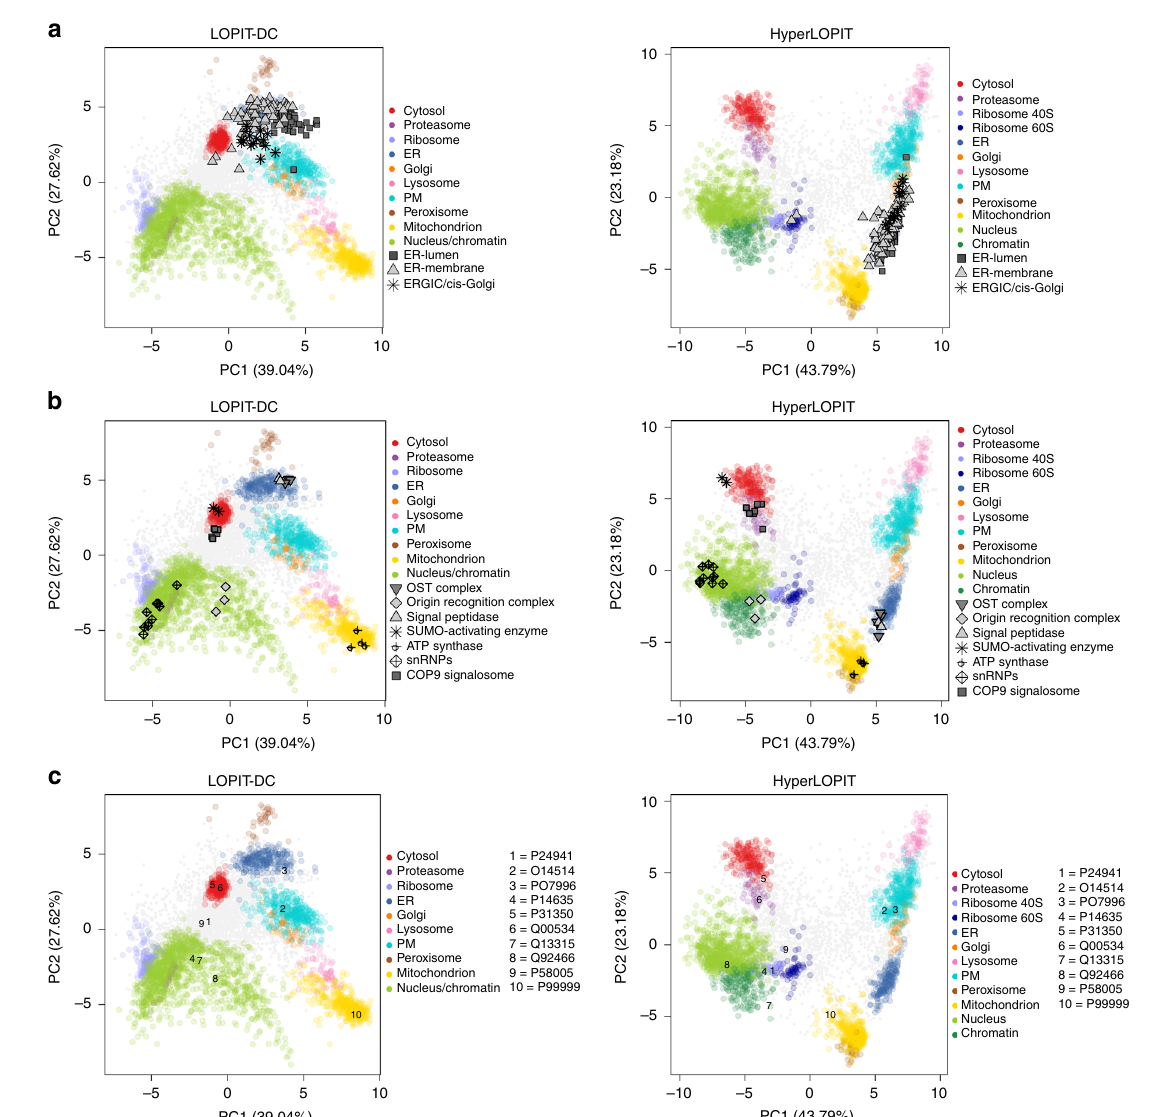
Fig. 7 Suborganellar structures, complexes and pathways in the LOPIT-DC and hyperLOPIT data. a ER-lumen, ER-membrane and ERGIC/cis-Golgi markers plotted upon the LOPIT-DC and hyperLOPIT datasets with assigned proteins. b COP9 signalosome, snRNPs, ATP synthase, signal peptidase, SUMO- activating enzyme, OST complex and Origin Recognition Complex plotted upon the LOPIT-DC and hyperLOPIT datasets with assigned proteins. c Ten proteins involved in p53 signalling plotted upon the LOPIT-DC and hyperLOPIT datasets with assigned